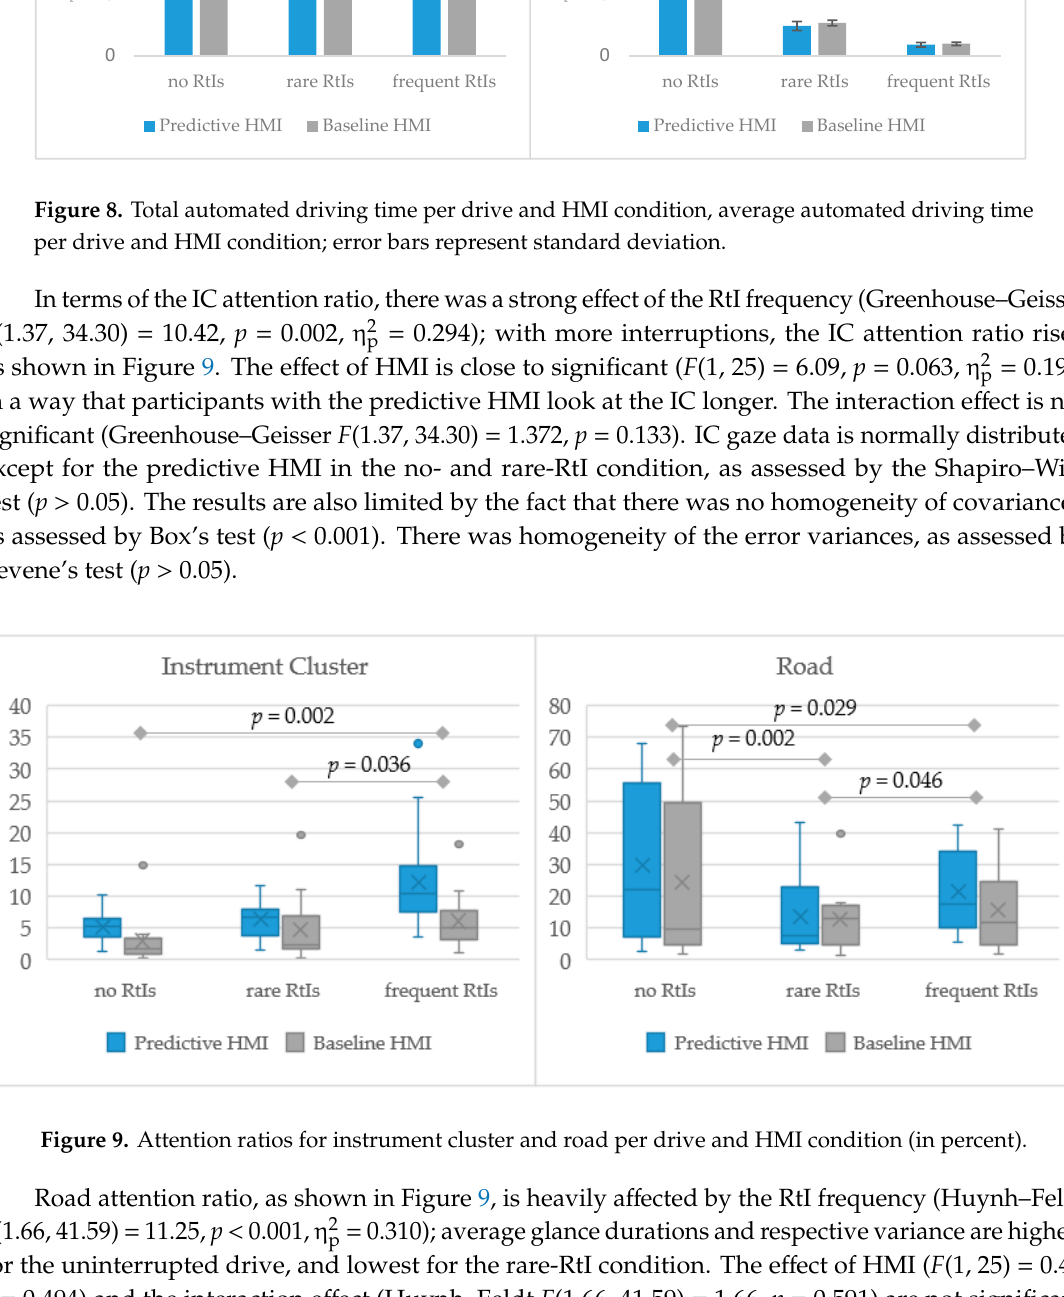
11 of 20 Figure 7. Participation rates for predictive HMI and baseline HMI group, per RtI condition. 3.4. Eye-tracking Data For analyzing eye-tracking data, obtained using Dikablis glasses, six additional participants were excluded due to not meeting quality criteria set in ISO 15007 [45] (70% detection rate). In terms of analyzing gaze data of the remaining 27 participants (predictive HMI group: 15; baseline HMI group: 12), three areas of interest (AOIs) were defined: instrument cluster (IC), road, and NDRA. As it was not possible to clearly distinguish the AOI NDRA due to different and moving items, we defined this AOI as everything that is not AOI road, AOI IC, or not detected. The monitoring ratio and AOI data were calculated. The monitoring ratio describes the ratio of gaze duration for the AOIs road and IC divided by gaze duration for AOI NDRA [46]. A monitoring ratio larger than 1 thus indicates control glances overweighting NDRA engagement and vice versa. In order to eliminate effects of manual driving, gaze behavior was assessed only during phases with activated automation. Different automation durations are caused by (a) more manual driving time that comes with more RtIs and (b) the acoustic RtI countdown in the predictive condition. Furthermore, some participants skipped some automated drives in the frequent condition (probably due to frustration or time needed